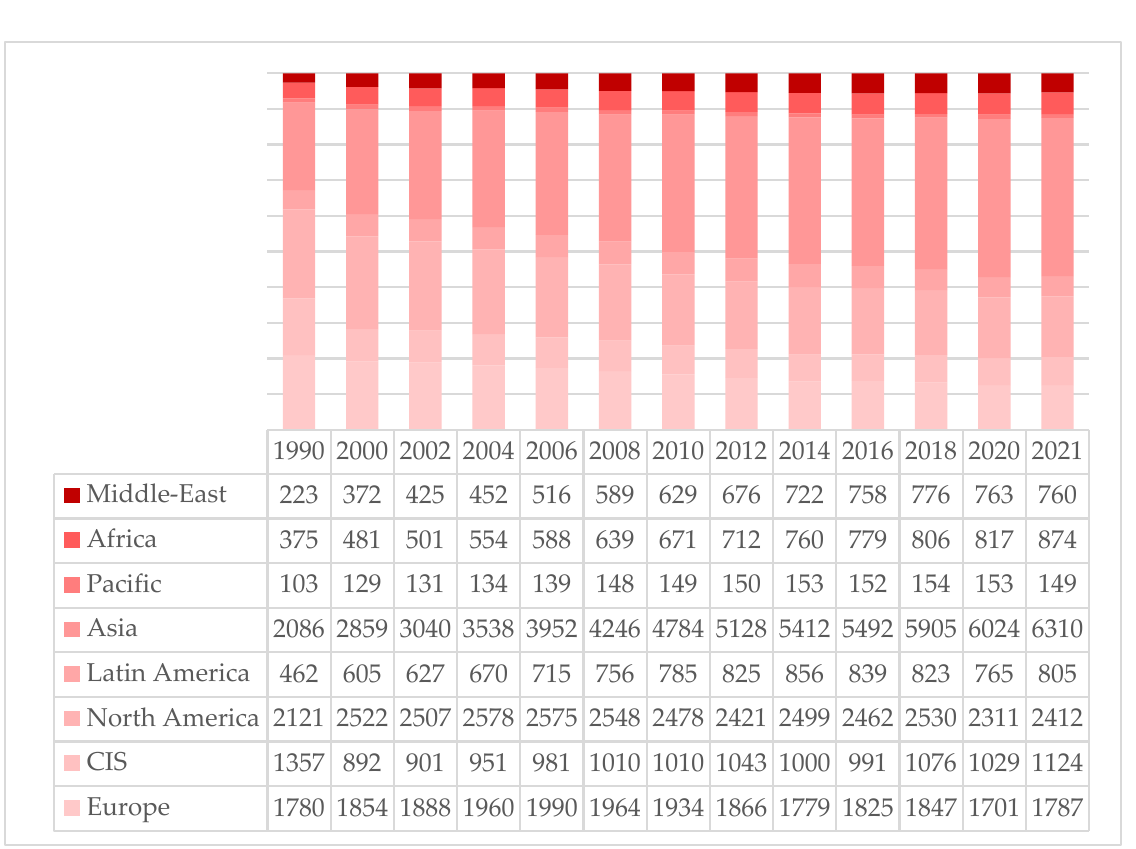
Figure 7. Total energy consumption by region for 1990; 2000–2020 (when analyzed in a 2-year period); 2021, Mtoe [28].